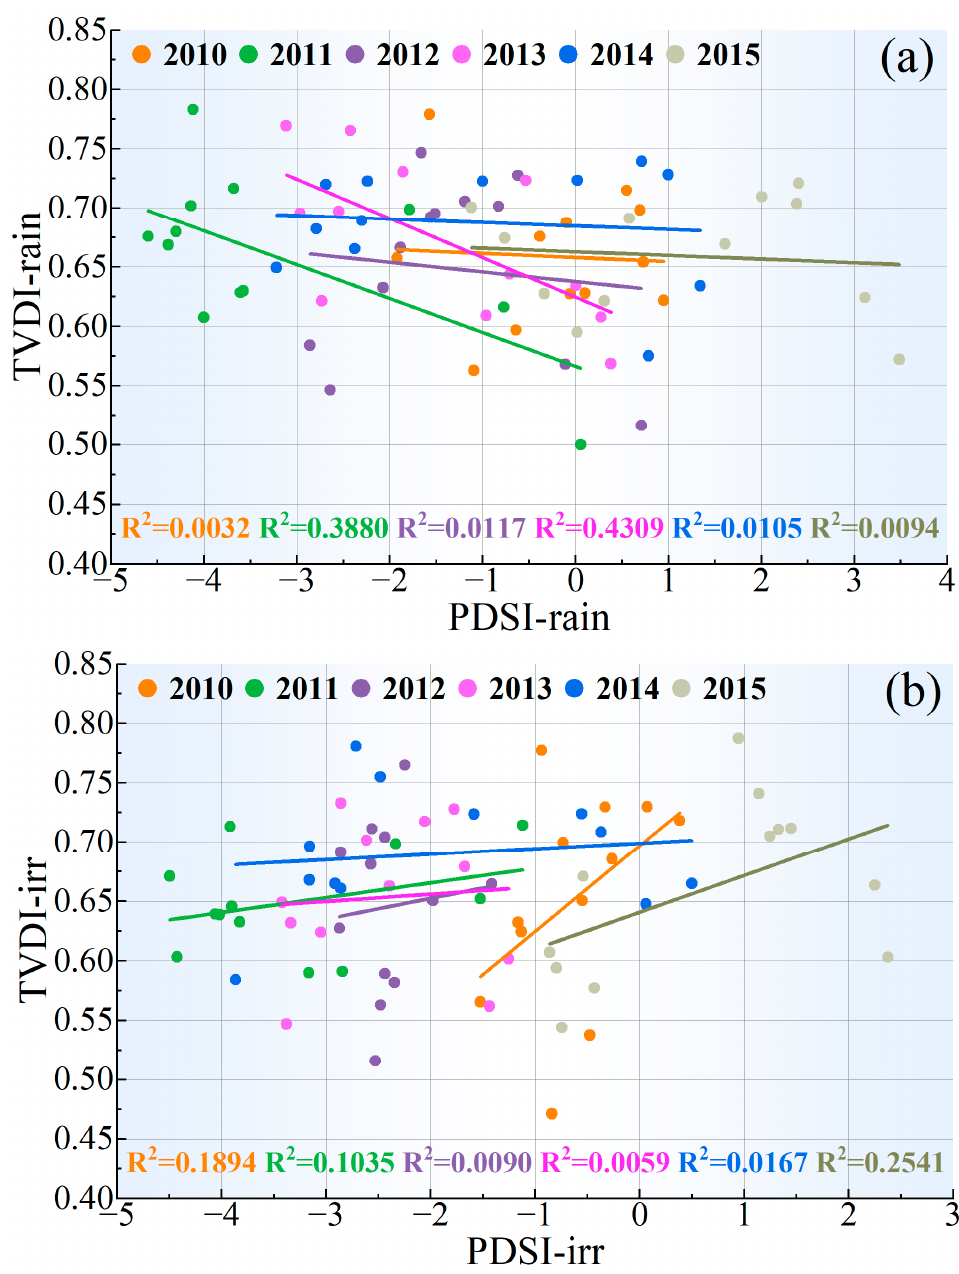
Figure 15. Correlation curves between the PDSI and TVDI of rain-fed arable land and irrigated arable land based on month averages in the middle and lower reaches of the Yangtze River from 2010 to 2015. Passed the significance test, with p < 0.05.( a ) The correlation curves of rain-fed arable land. ( b ) The correlation curves of irrigated arable land.